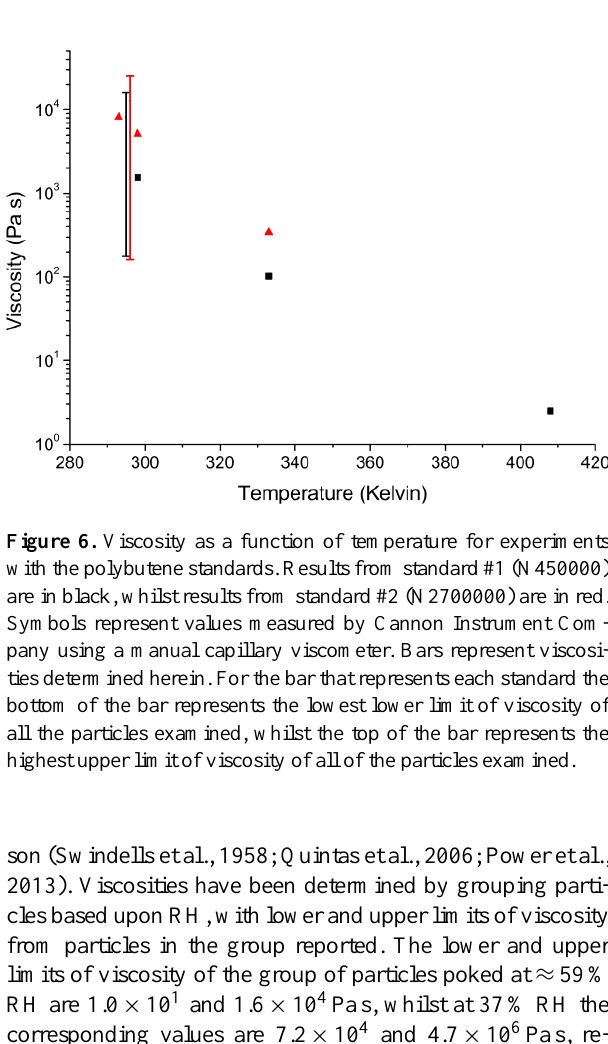
Figure 5. Optical images of particles of polybutene standards, (a) standard #1 (N450000) and (b) standard #2 (N2700000), being poked at 0% RH recorded during typical poke-flow experiments. Images a1 and b1 correspond to particles prior to poking. Images a2 and b2 correspond to the first frame post-poke (i.e. the first frame after the needle has been removed). Images a3 and b3 correspond to images of the experimental flow time, τ exp, flow , the point at which the equivalent area diameter of the hole at the centre of the torus has decreased to 50% of its original size. Images a4 and b4 correspond to the final frame recorded of each particle, at which point each particle has re-attained its original spherical cap geometry. Size bar: 20µm.